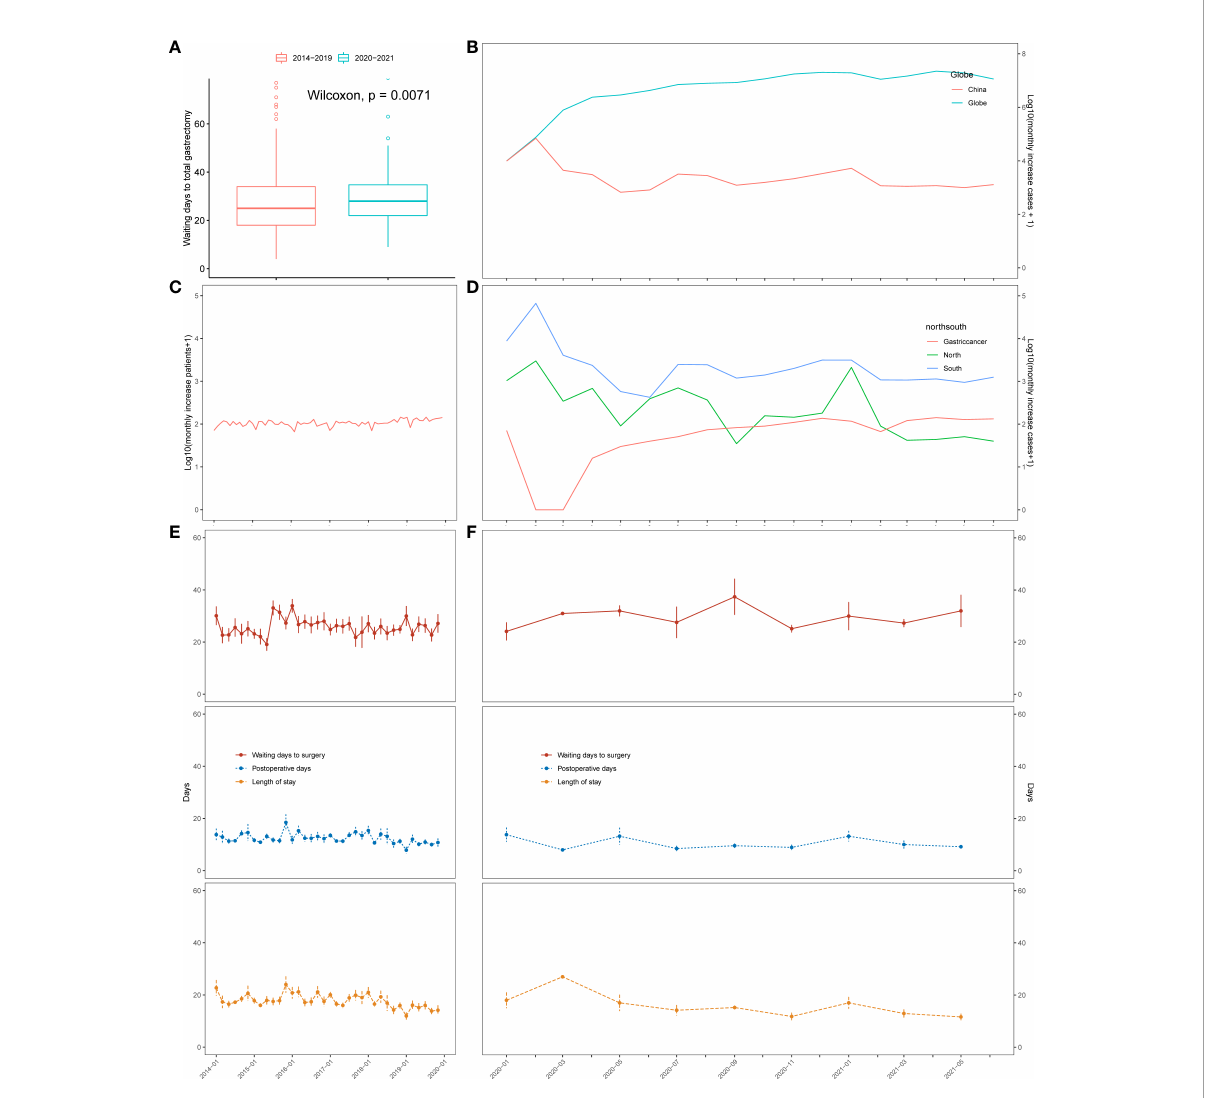
FIGURE 2 Changes in the severity of the pandemic, number of patients, and the waiting time in days for total gastrectomy based on time series analysis. (A) Boxplot of waiting time for total gastrectomy before and after 2020. (B) Monthly rise in COVID-19 cases in China and across the globe. (C) Changes in the number of surgical cases over time from 2014 to 2019. (D) Changes in the number of COVID-19 cases in north China (blue) and south China (green). Number of surgical cases (red) over time from 2020 to 2021. (E) Changes in the waiting time for total gastrectomy, length of stay, and postoperative days over time from 2014 to 2019. (F) Changes in the waiting time for total gastrectomy, length of stay, and postoperative days over time from 2020 to